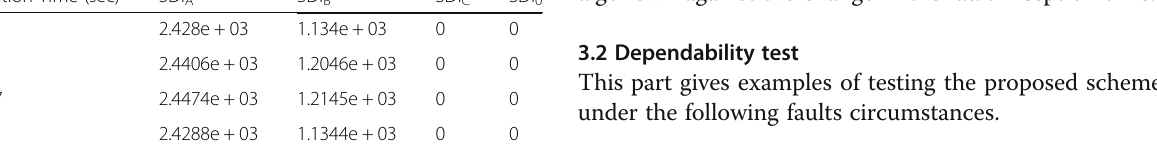
Table 2 SDI values during AB occurred at different FIT Inception Time (sec)